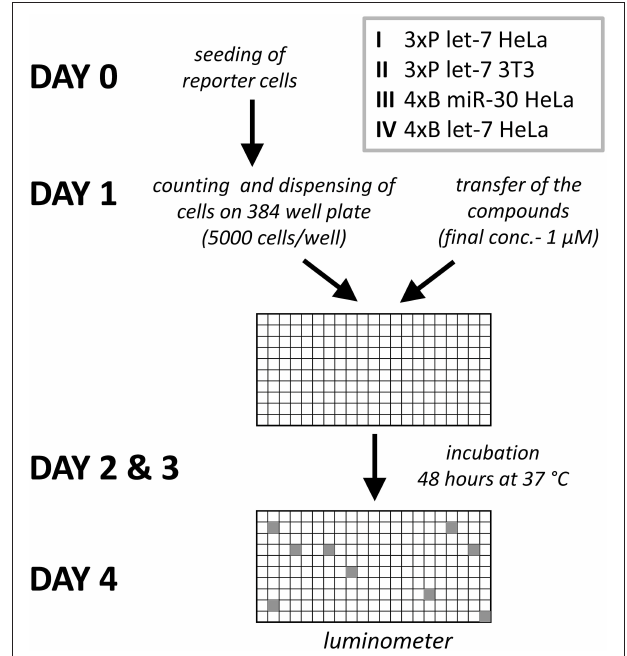
FIGURE 2 | Workflow of HTS with the four miRNA reporter